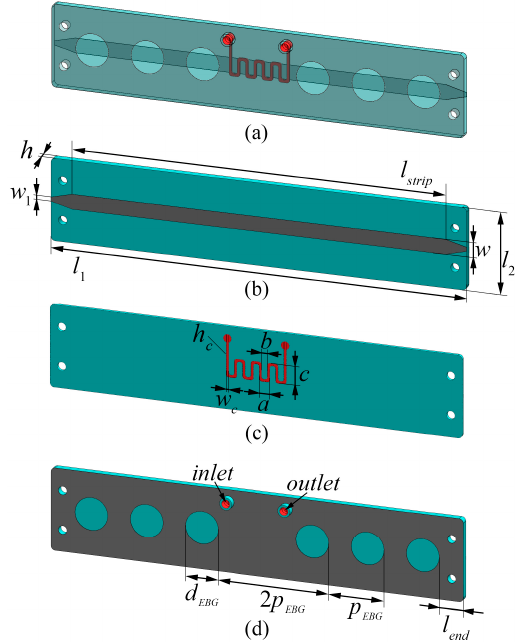
Figure 1. The layout of the proposed microfluidic electromagnetic band gap (EBG) sensor: ( a ) 3D view; ( b ) top layer; ( c ) substrate with embedded microfluidic channel; ( d ) bottom layer with defected EBG structure. EBG